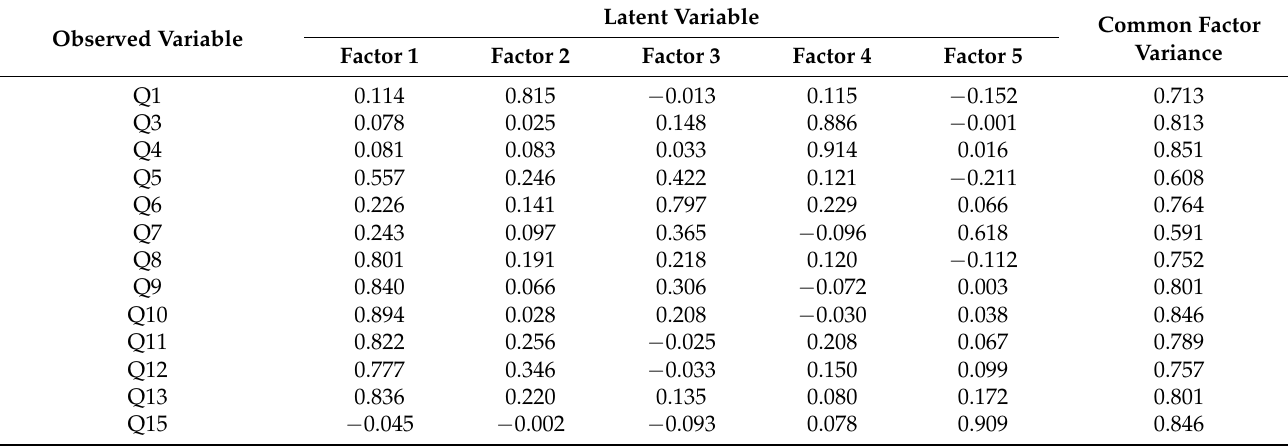
Table 6. Validity analysis of 19